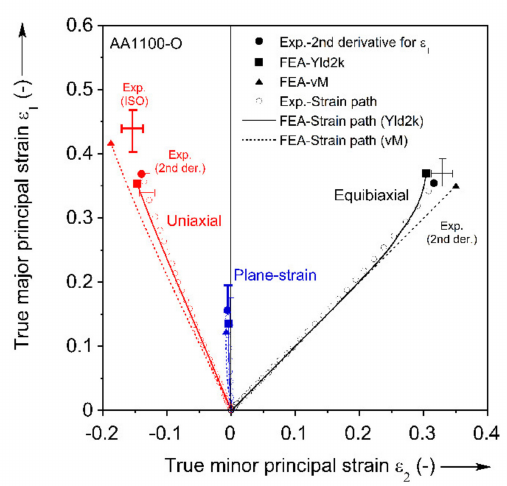
Figure 23. Comparison of experimental and predicted strain paths. Also shown are the experimental FLC points and associated error